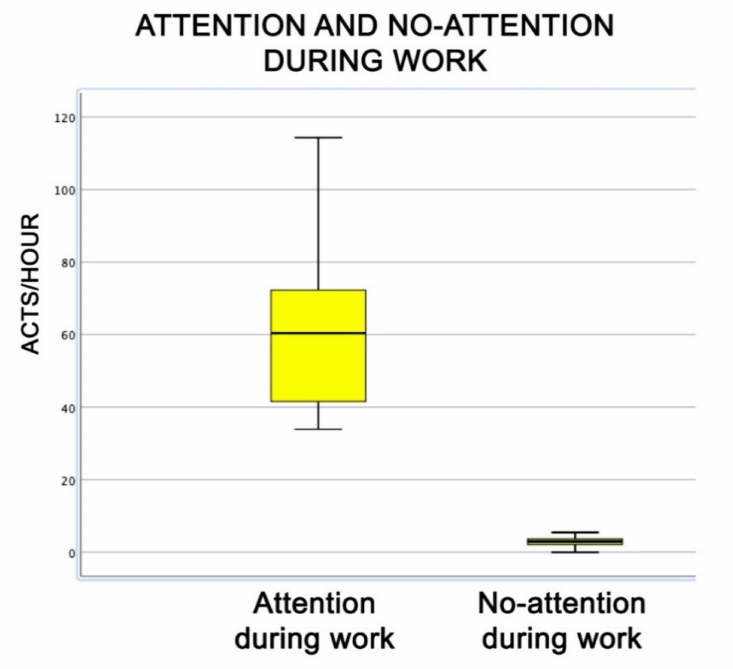
Figure 10. Behavioural patterns related to dogs’ level of attention / no attention to work during the AAI sessions. Non-parametric data are represented as medians (horizontal bar in the box) and the box indicates the interquartile range of 50% of the data. Whiskers extend to the smallest and largest values and exclude outliers (dot on